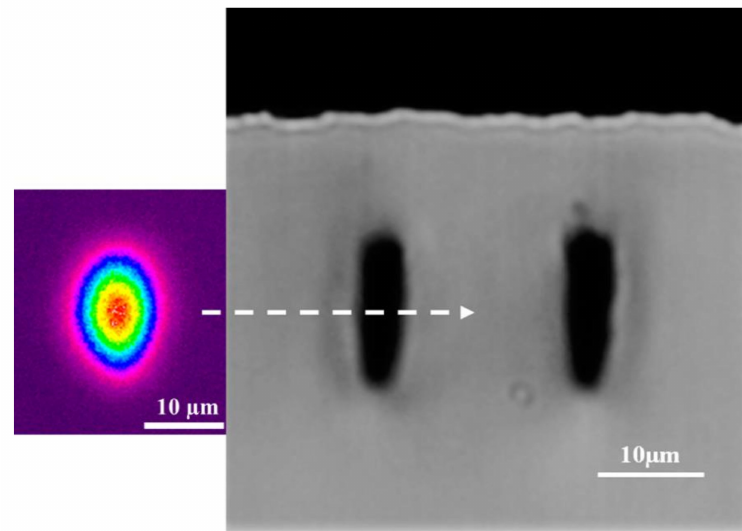
Figure 1. Cross sectional microscope image of one facet of the shallow diamond waveguide written at a depth of d = 20 µ m (surface to center of modification) and a Type II separation of 19 µ m, which exhibits an insertion loss of 12.4 dB. On the left of the microscope image is the near-field mode profile of the waveguide.